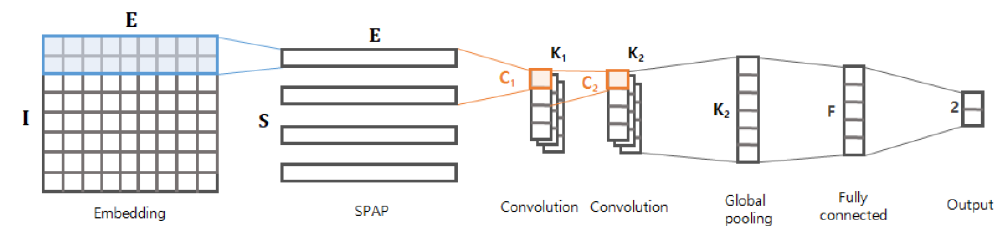
Figure 1. Malicious/benign byte streams within HWP files.